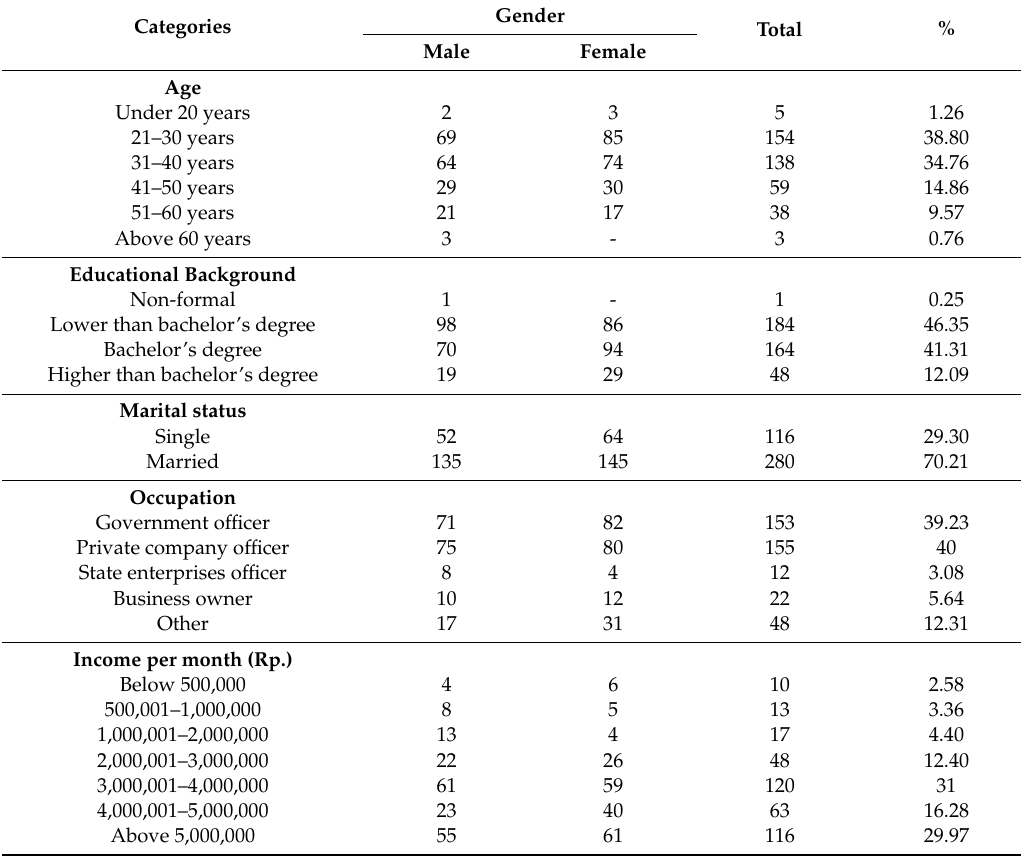
Table 5. Characteristics of the